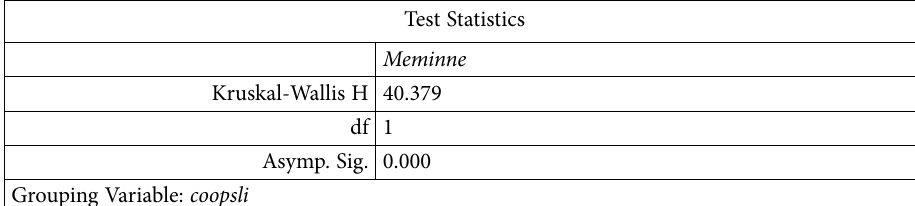
Table 3. Kruskal Wallis test – H1 (source: authors’